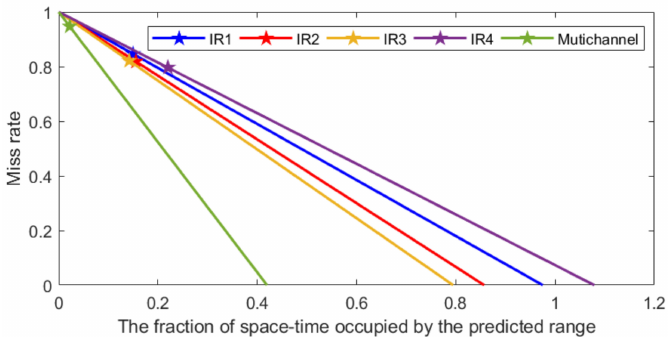
Figure 21. Molchan diagram of different methods.